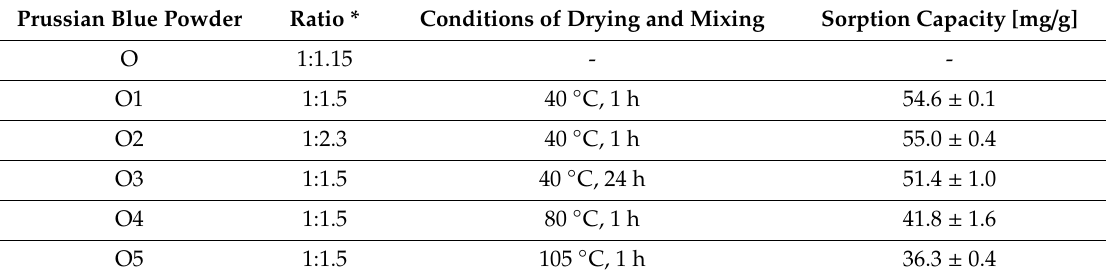
Table 1. Parameters of Prussian blue (PB) powder synthesis and sorption capacity of PB-only powders. Prussian Blue Powder Ratio * Conditions of Drying and Mixing Sorption Capacity [mg / g] O 1:1.15 - -